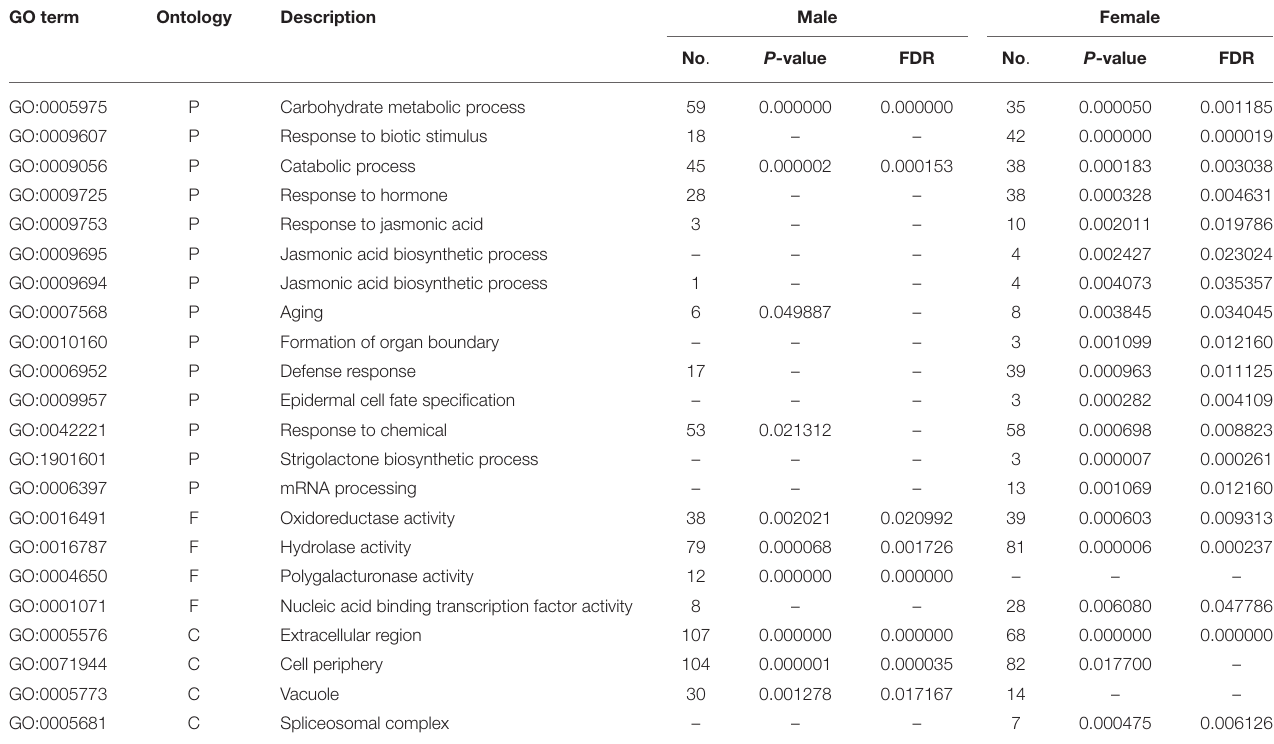
TABLE 1 | GO ontology (GO) enrichment analysis of DEGs between male and female flowers. GO term Ontology